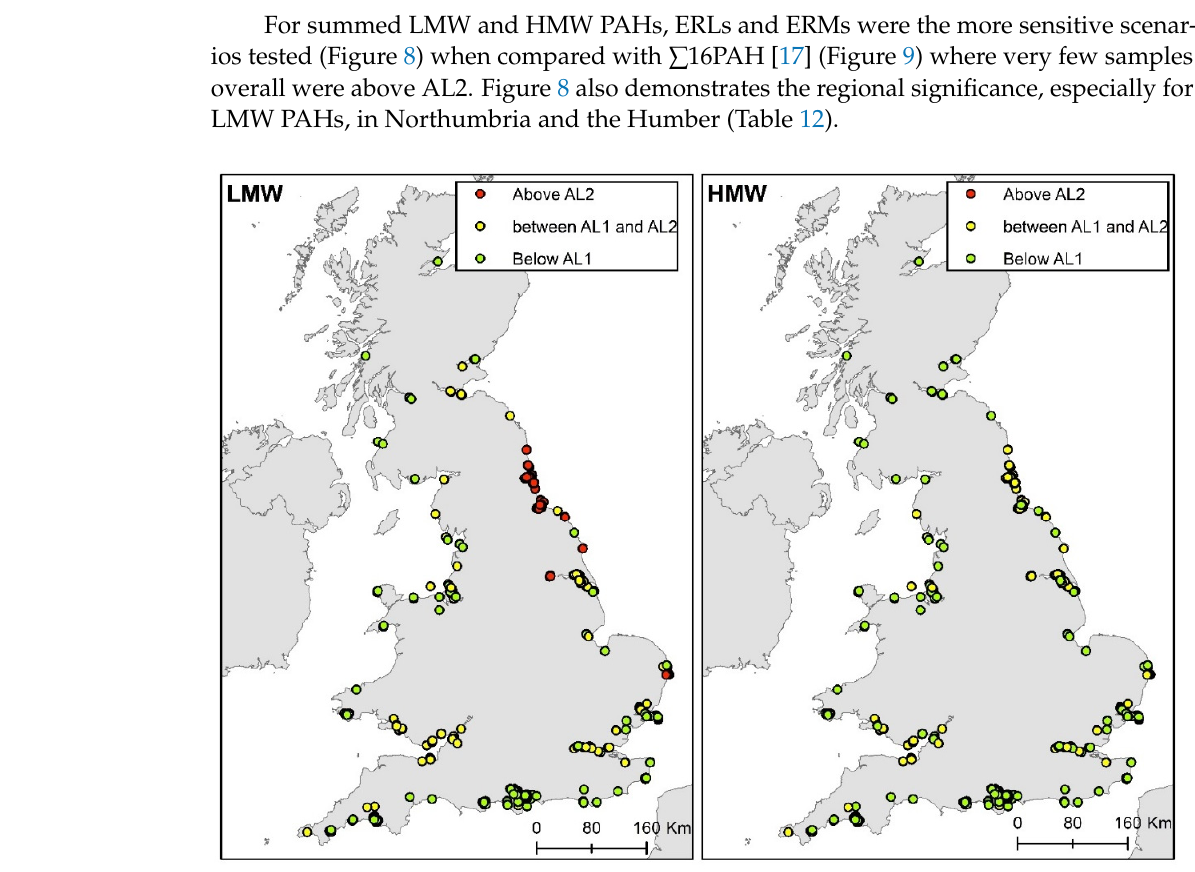
Figure 9. Maps showing summed 16PAHs [17] (Table 13). Samples above AL2 are indicated in red. Figure adapted from [13].